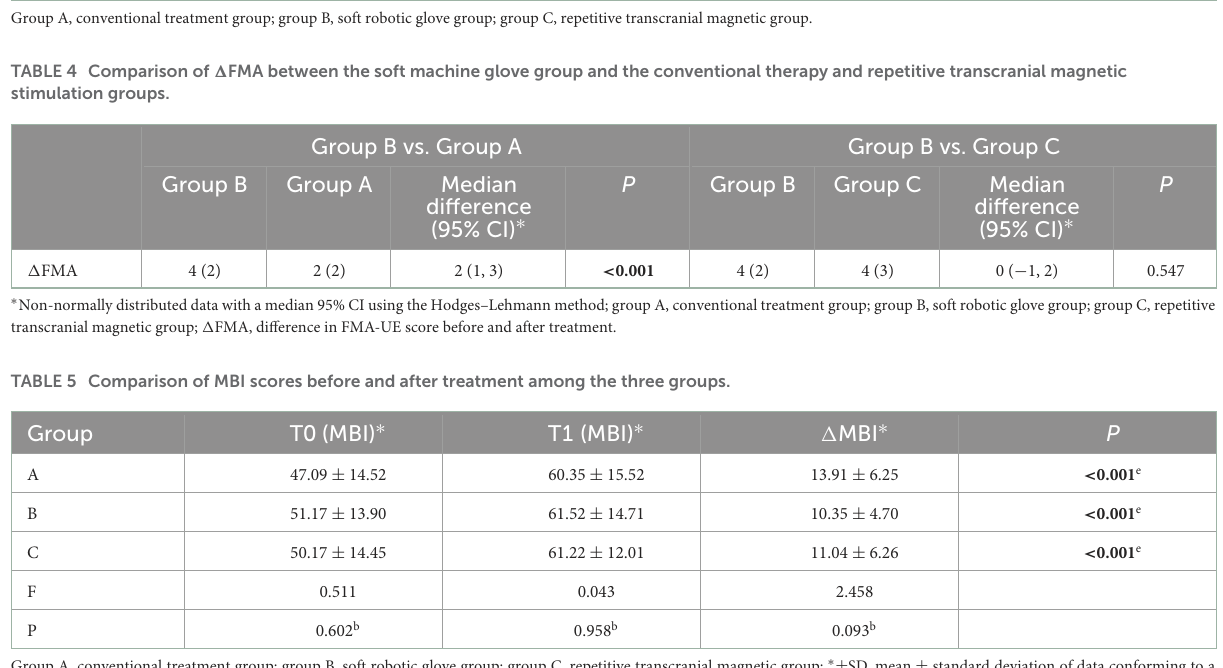
TABLE 3 Pairwise comparison of the difference in FMA-UE scores between the three groups before and after treatment. H P P (A vs. B) P (A vs. C) P (C vs. B) 1 FMA 20.030